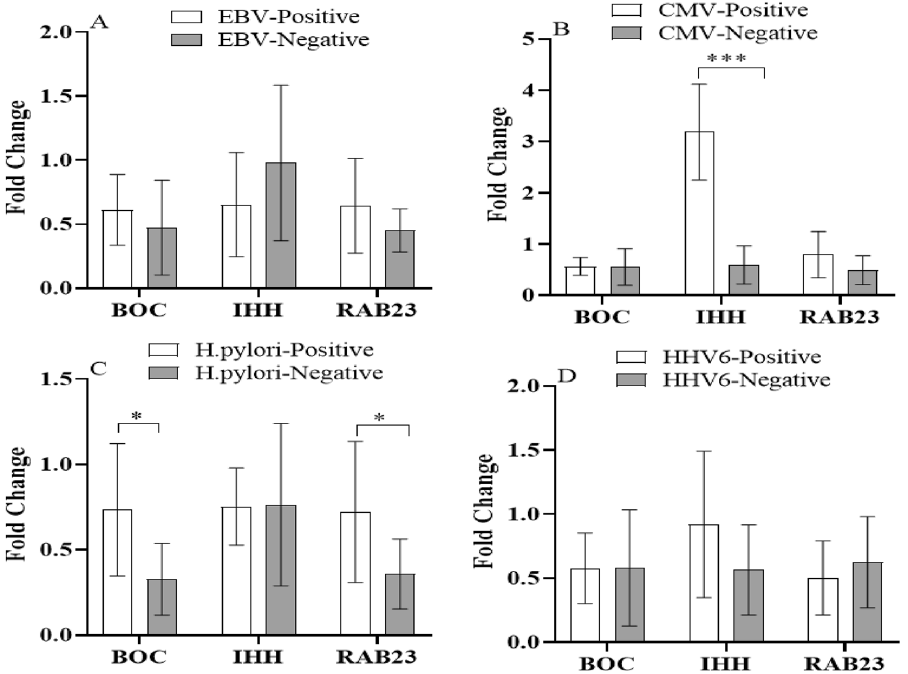
Figure 6. Expression level of Shh signaling pathway genes in non-tumoral and tumoral gastric cancer tissues according to viral infections. * and *** indicate significant difference P < 0.05 and P < 0.001, respectively. EBV; Epstein-Barr virus, CMV; Cytomegalovirus, HHV6; Human herpesvirus 6.